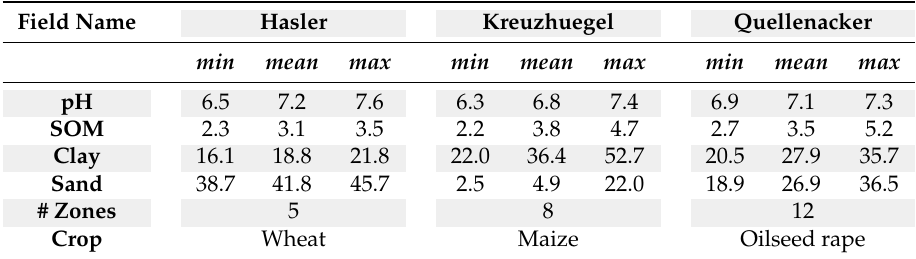
Table 1. Statistical summary of soil zoning and soil property predictions for the four presented fields that were sampled in the first field